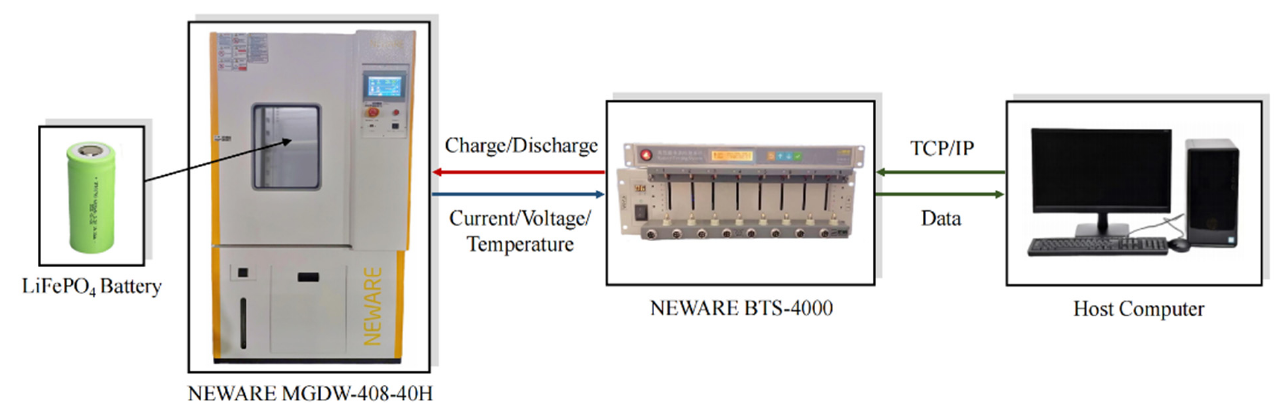
Figure 3. Battery test platform configuration.